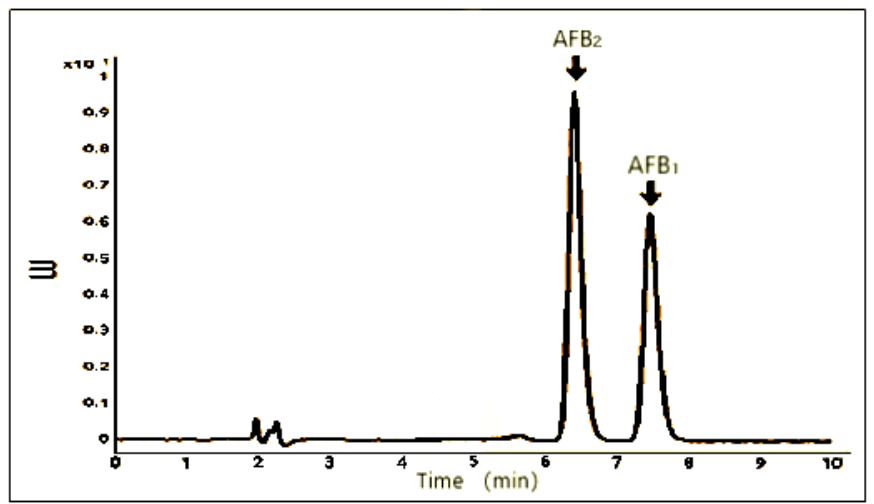
Figure 5. Representative HPLC chromatograms of AFB 1 and AFB 2 in the culture of A. flavus detected by FLD.